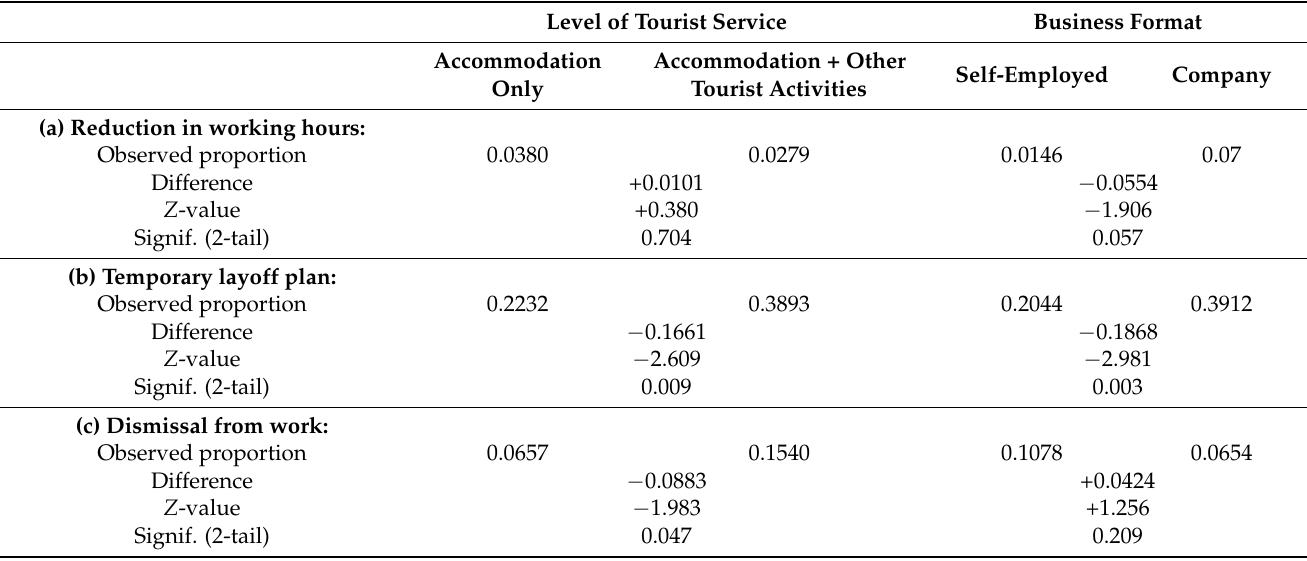
Table 2. Comparison of proportions of workers in rural accommodation affected by the COVID-19 mandatory